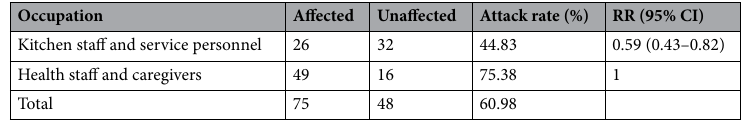
Table 3. Attack rates and rate ratio (RR) in long-term care facilities staff according to occupation.